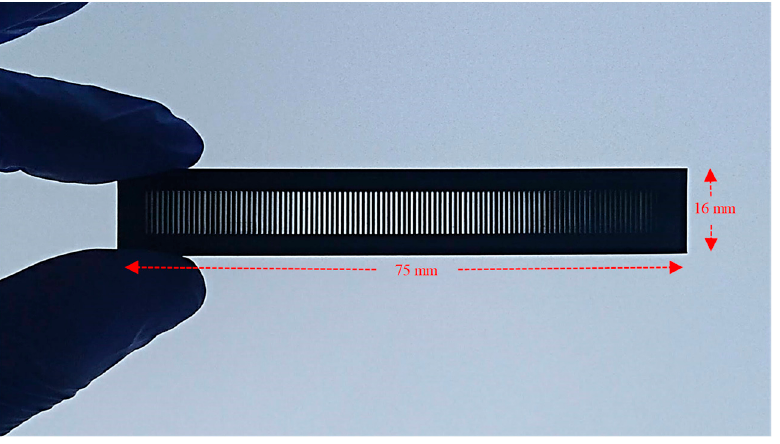
Figure 4. Picture of the 3D printed amplitude mask.